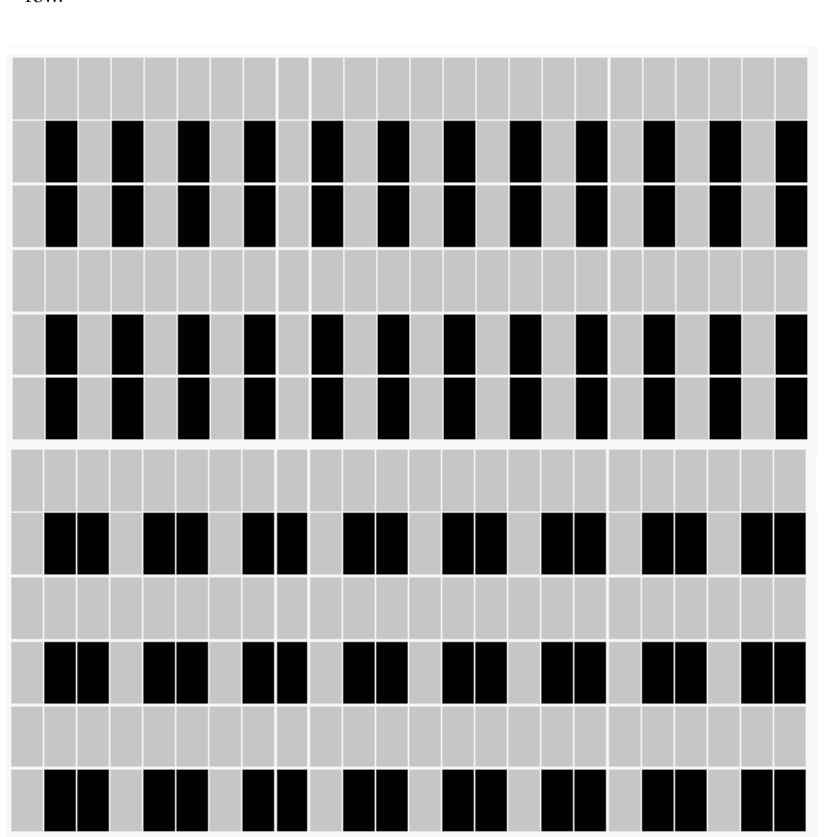
Figure 2. Semitransparent PV with 33% covered agrivoltaic panel using parameters 2/3 ( top ) and 3/2 ( bottom ) for